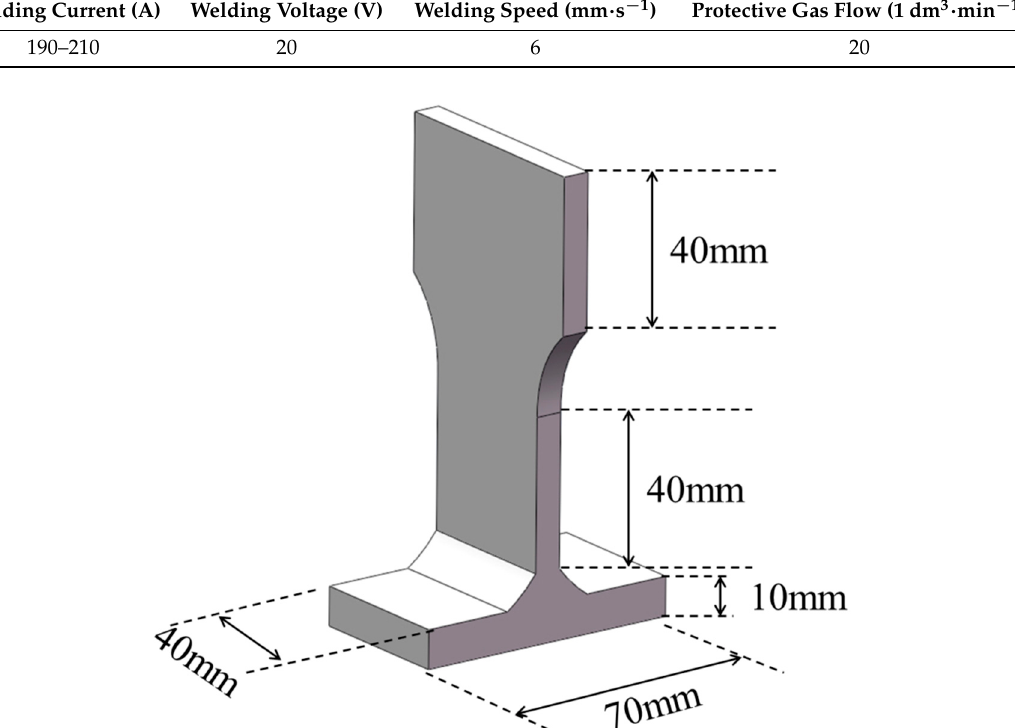
Figure 1. Schematic diagram of metal inert gas (MIG) welding. Table 3. Welding parameters of the 6082 aluminum alloy.